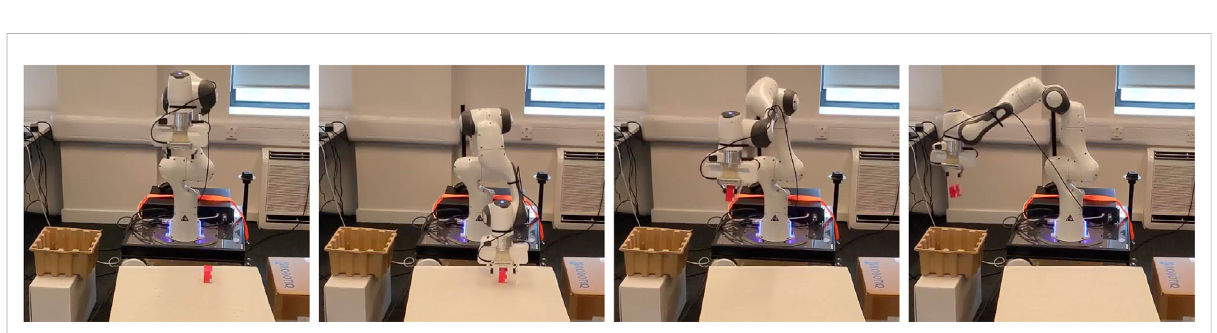
Frontiers in Robotics and